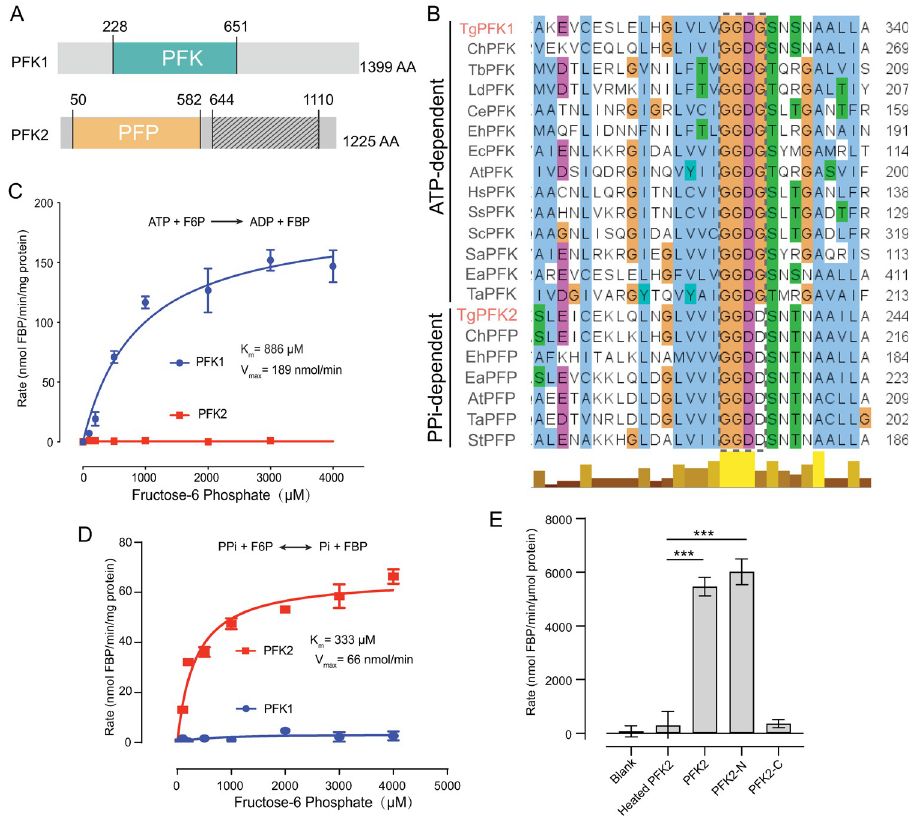
Fig 1. Toxoplasma expresses two PFKs that are PPi- and ATP-dependent. A , Conserved domains in Toxoplasma PFK1 and PFK2, as determined by BLAST analyses. PFK: phosphofructokinase, PFP: PPi-dependent phosphofructokinase. The shaded region (644–1110) in PFK2 is a pseudo-PFK domain that lacks key residues for activity. B , Sequence alignments of two types of PFKs from selected species. The “GGDD/G” motif that specifies the substrates is boxed in gray. C-D : ATP- and PPi-dependent activities of recombinant PFK1 and PFK2 when assayed under different F6P concentrations. Each assay was repeated three times independently. E , Enzymatic activity of the N (PFK2-N, 1–595) and C (PFK2-C, 597–1225) terminal domains of PFK2 in the presence of 4 mM F6P. PBS (Blank) and heat inactivated PFK2 (Heated PFK2) were included as negative controls. ��� P < 0.001, paired student’s t-test (n =